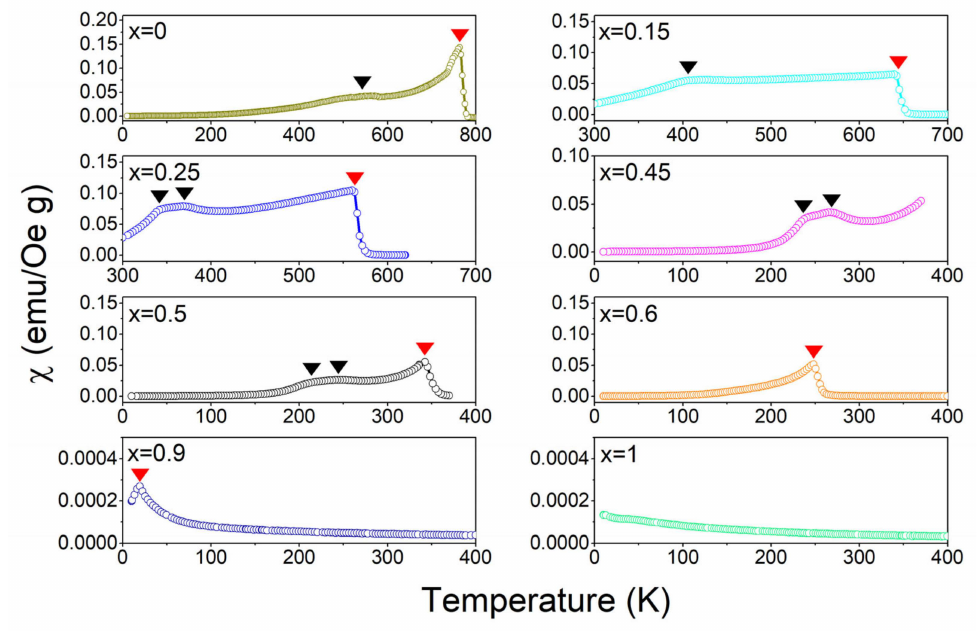
Figure 3. (Color online). The magnetic susceptibility versus temperature curves for Co(Fe 1 − x Al x ) 2 O 4 ( x = 0.0, 0.15, 0.25, 0.45, 0.5, 0.6, 0.9, 1.0). The red triangle denotes the Curie transition, and the black ones denote the ferrimagnetic-ferrimagnetic transition.